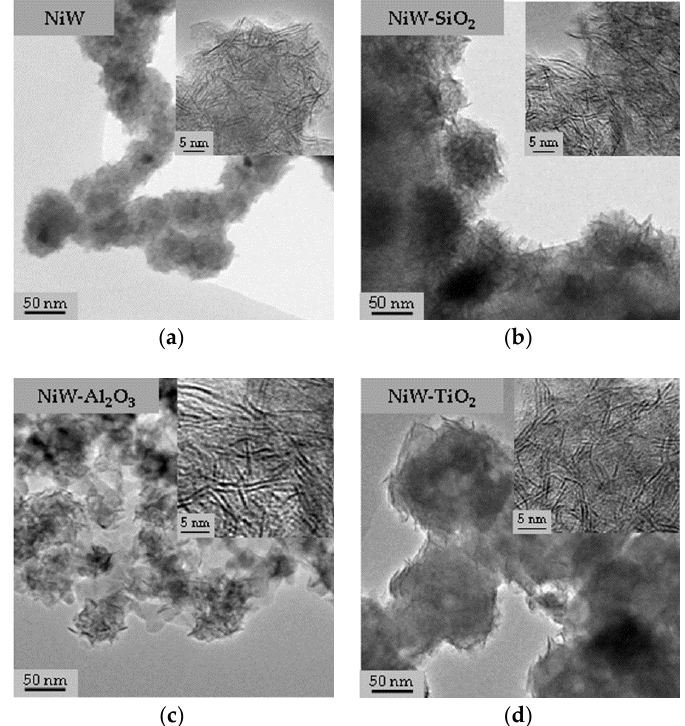
Figure 2. TEM micrographs of the catalysts prepared ( a ) without additives and with oxide additives ( b ) SiO 2 , ( c ) Al 2 O 3 , ( d ) TiO 2 (390 ◦ C, 5.0 MPa, 5